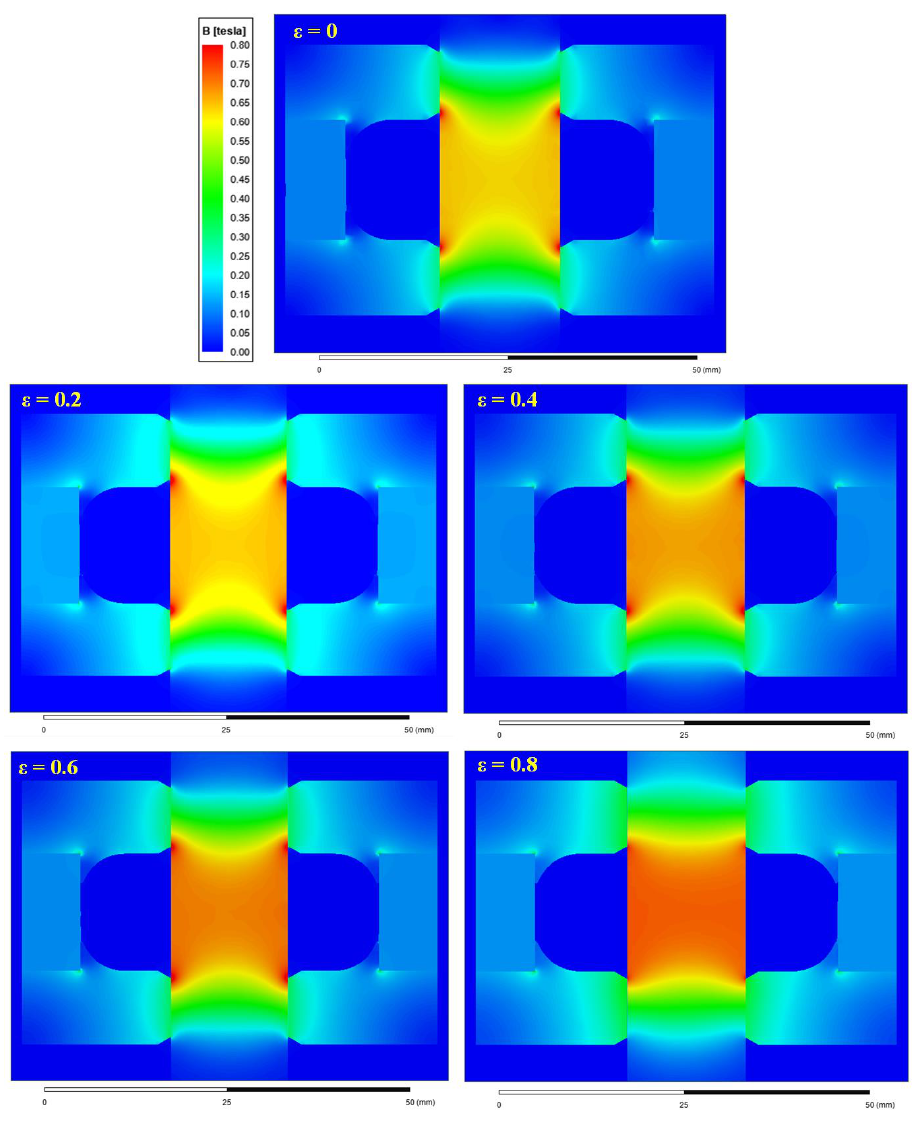
Figure 12. Magnetic field distribution along the axial section of the bearing.